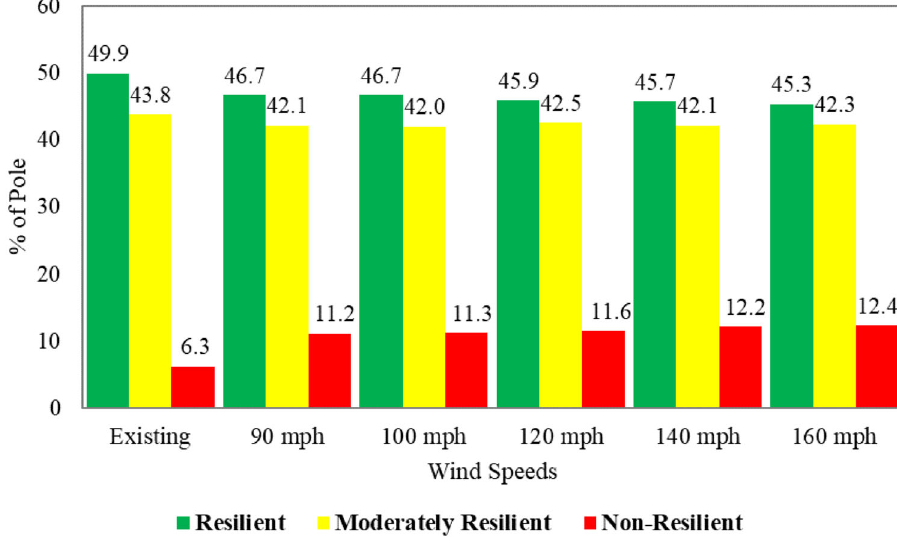
Fig. 5 Changes in